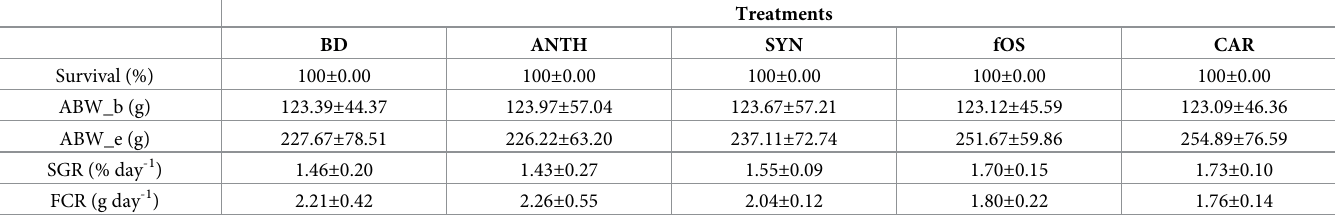
Table 1. Growth performance of common carp juveniles at the end of the feeding trial (means ± SE, n = 3), and ABW at the beginning (_b), and end (_e) of experiment.